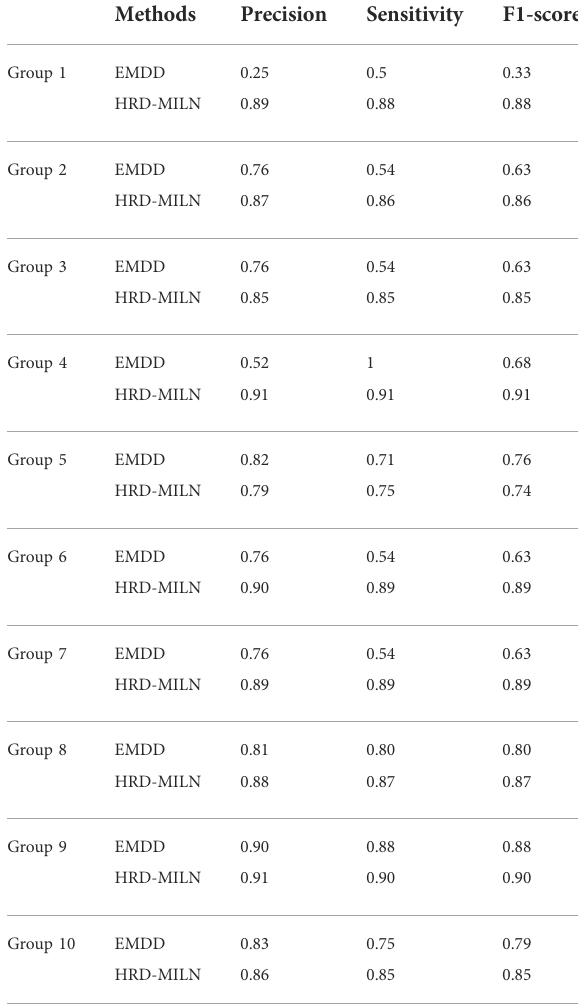
TABLE 4 HRD-MILN vs. EMDD. We compared various aspects of HRD detection performance of HRD-MILN and EMDD on the